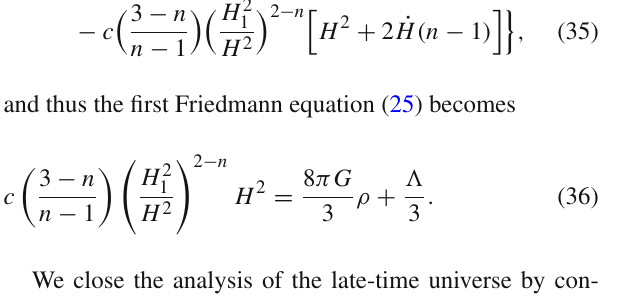
corresponding χ 2 is calculated